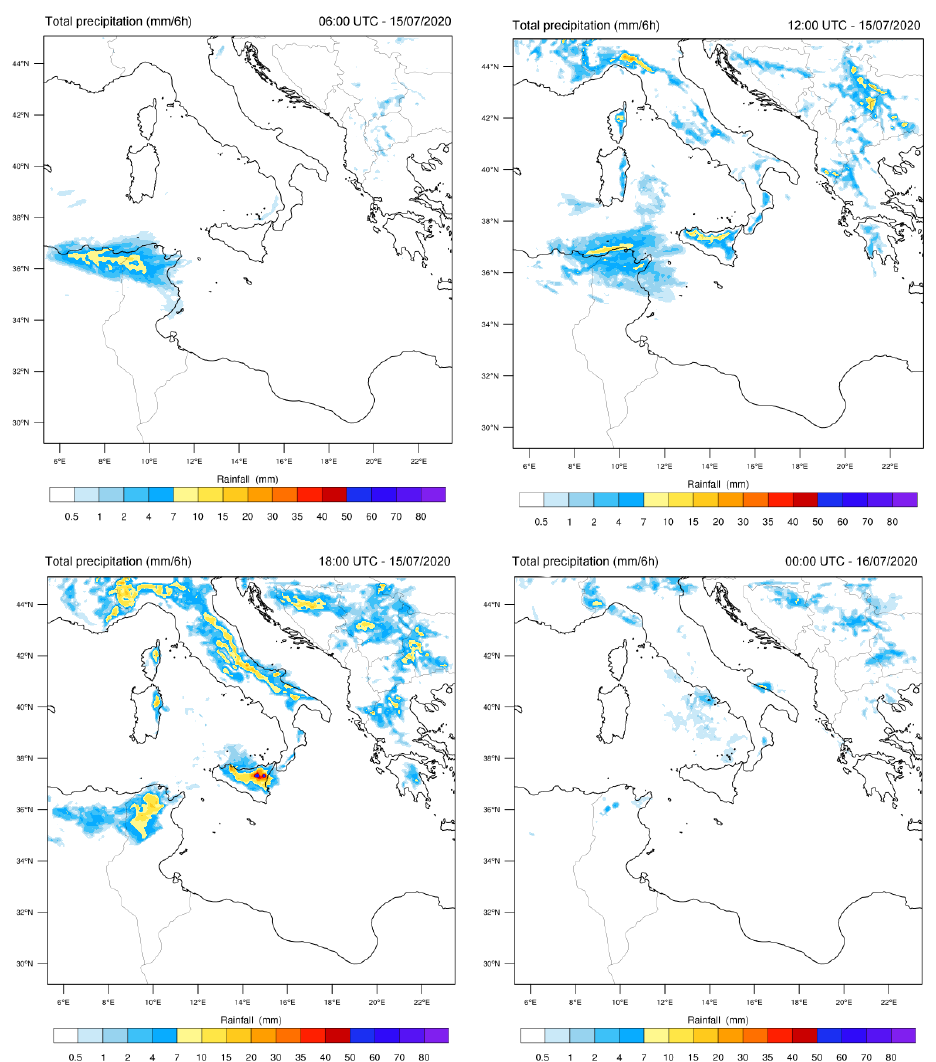
Figure 19. Cumulative rainfall every six hours predicted by the WRF model with a domain of 9 km and calculated at 06:00 UTC ( top left ), 12:00 UTC ( top right ) and 18:00 UTC ( bottom left ) of 15 July 2020, and 00:00 UTC ( bottom right ) of 16 July